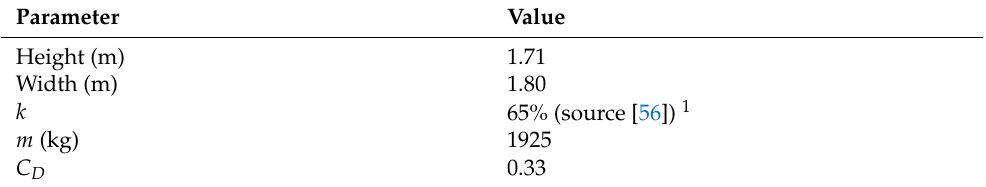
Table 3. Vehicle parameters (PHEV).